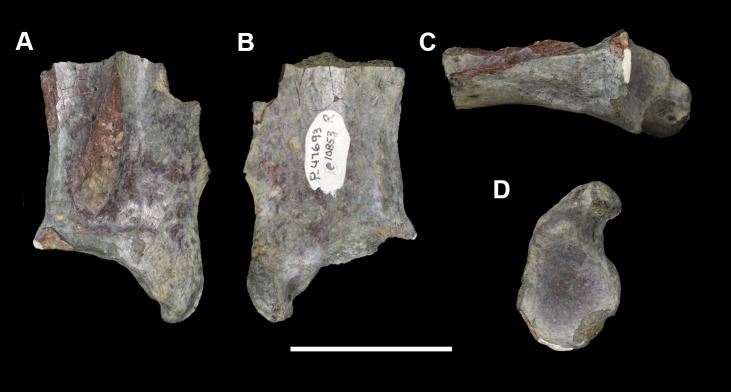
Right scapula of Periptychus carinidens (NMMNH P-47693).(A) lateral view; (B) medial view; (C) posterior view; (D) distal view. Scale bar: 30mm.